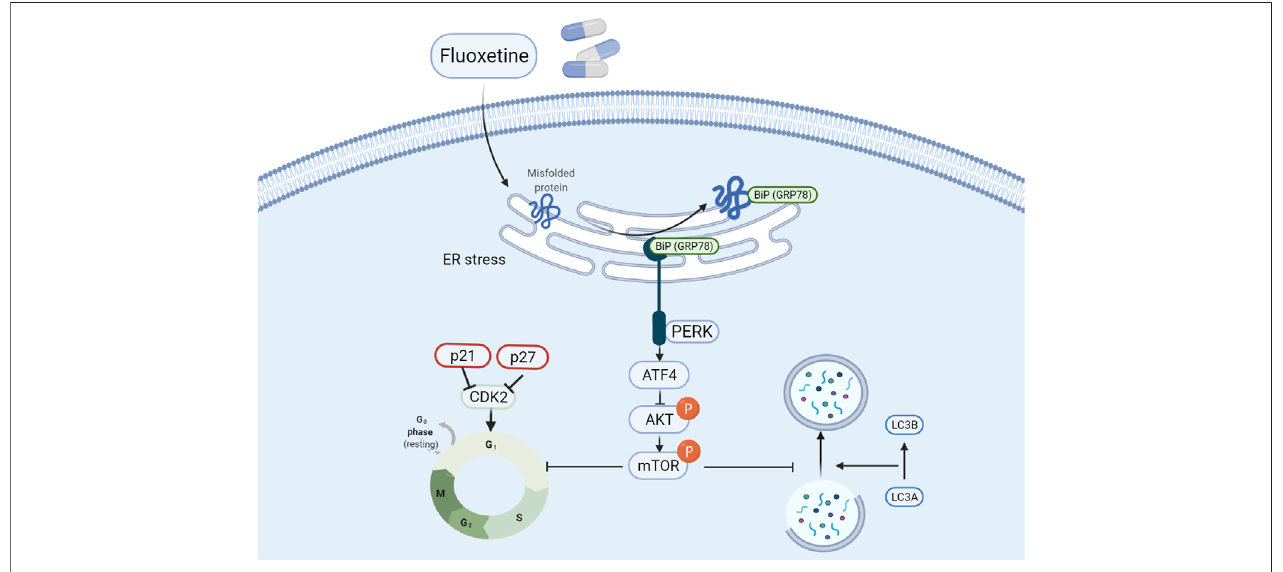
FIGURE 9 | Fluoxetine induced cell cycle arrest and autophagy by triggering ATF4-AKT-mTOR signaling pathway in lung cancer cells. Brie fl y, fl uoxetine activated